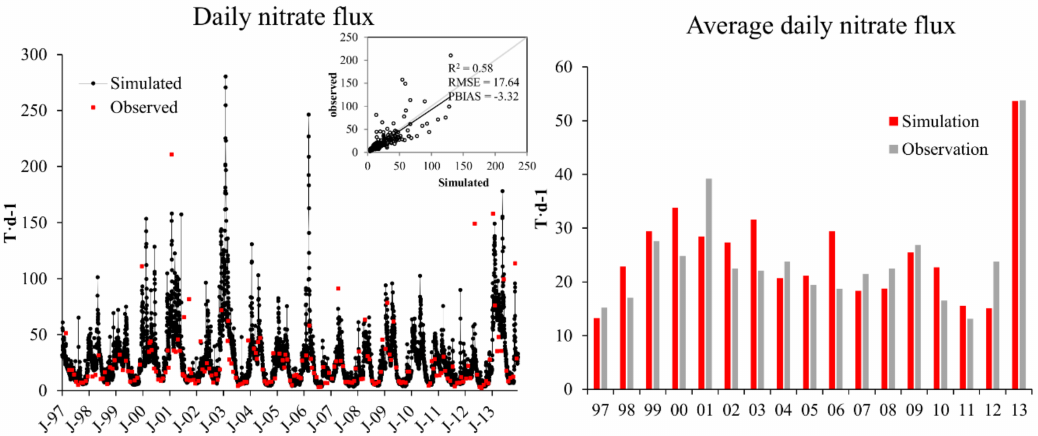
Figure 7. Simulated and observed nitrate content at the outlet of the study area. R 2 = the coefficient of